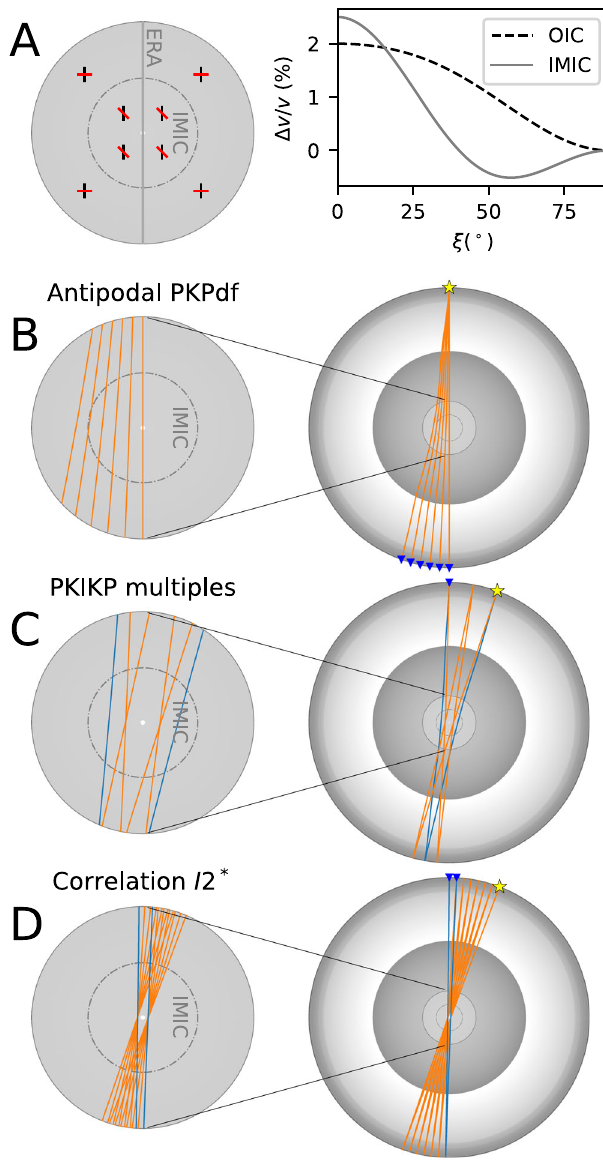
Fig. 4 | Schematic model of the inner core (IC) containing an innermost inner core (IMIC) and various body-wave probing methods to the Earth ’ s center. A On the left panel, the IC model contains IMIC with two distinct P-wave trans- versely isotropic patterns in outer inner core (OIC) and IMIC; black and red bars representthefastandslowanisotropicdirection;averticalgraylinerepresentsthe Earth ’ s rotation axis (ERA). On the right panel are cylindrically anisotropic models of OIC (black dashed line) and IMIC (gray line). Schematic views of IMIC-sampling methods using ( B ) absolute PKIKP waves, ( C ) PKIKP multiples (this study) – blue and orangeraylines represent ray pathsofthe second and fourthPKIKP multiples, and ( D ) correlation feature I2* at the two receivers (blue ray paths) results from cross-correlating high-multiples of PKIKP (orange ray paths). The cross-sections of theEarthintherightcolumncontainraypathsegmentssamplingtheOICandIMIC. Yellow stars are sources, and blue inverted triangles are